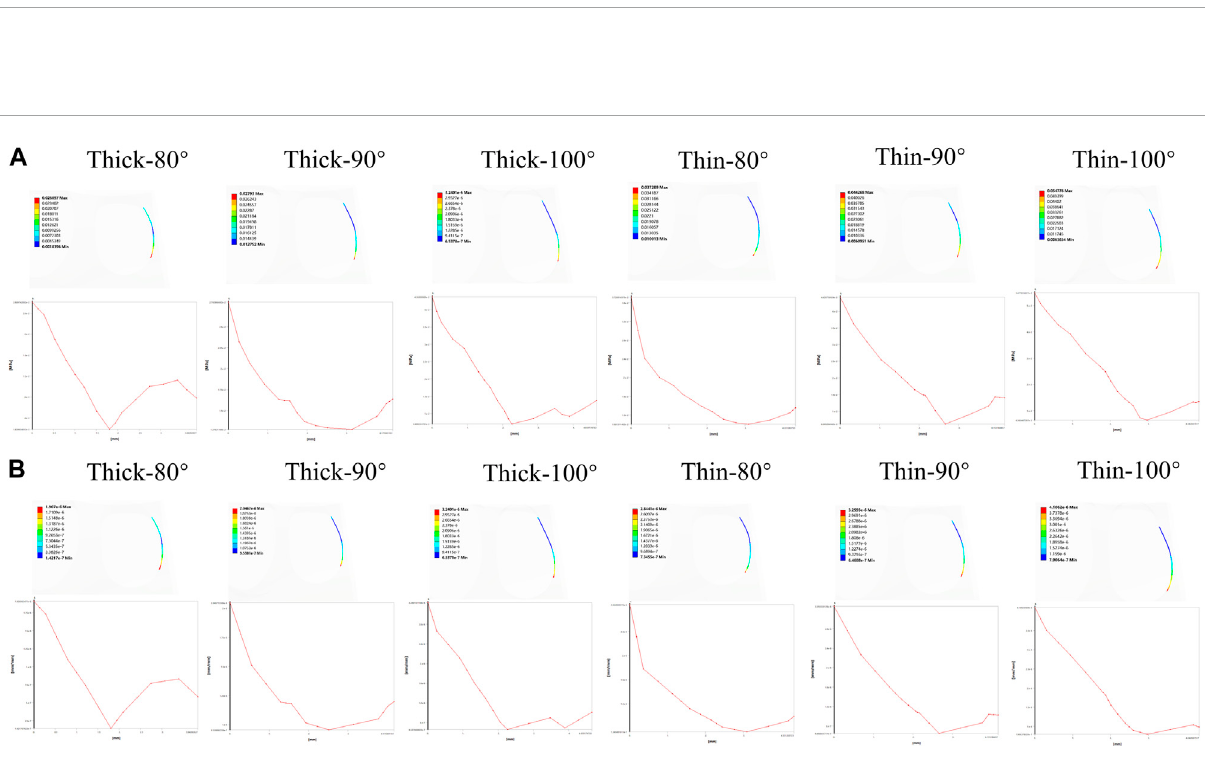
Frontiers in Bioengineering and